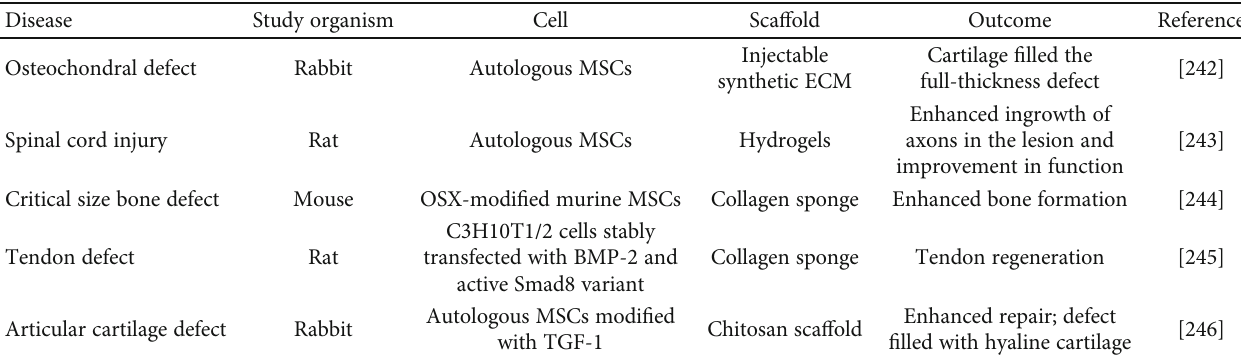
Table 6: Tissue engineering therapies using